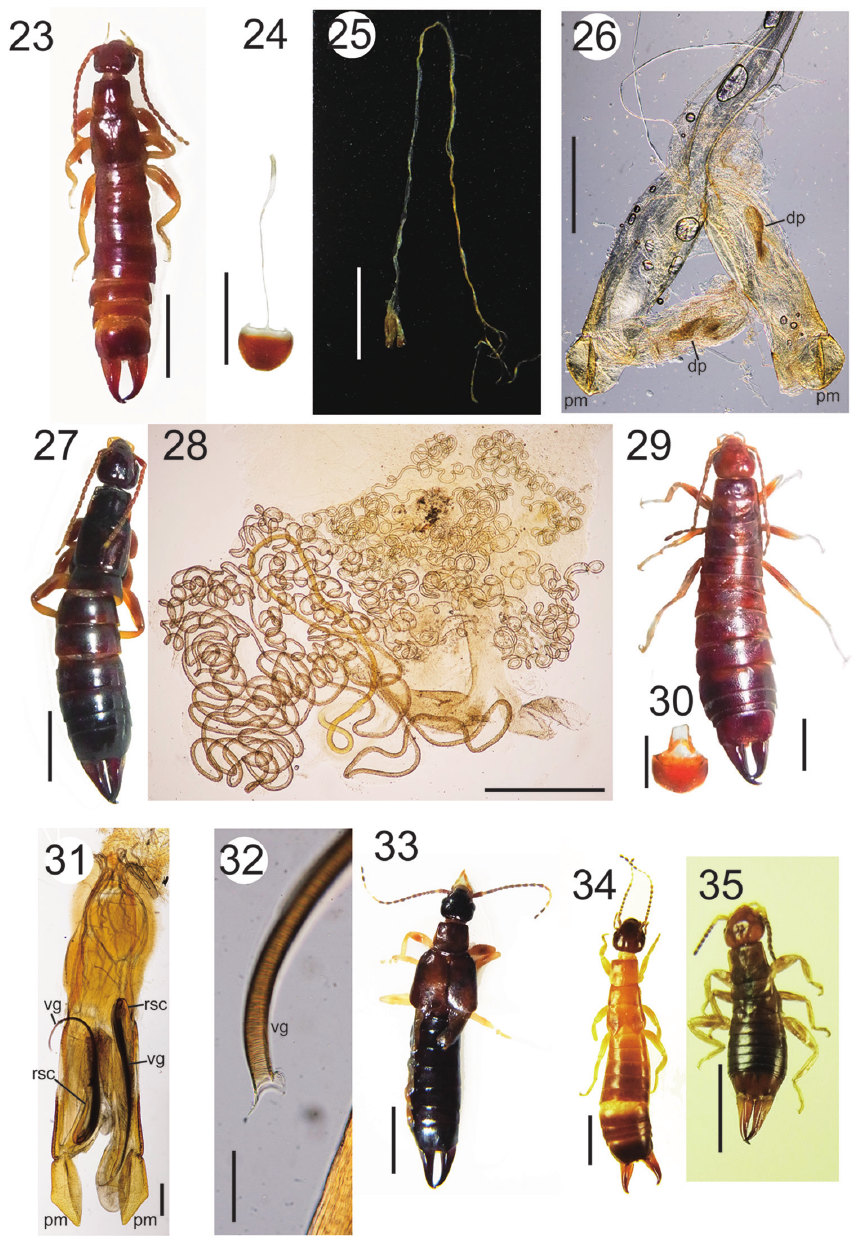
genitalia ( 25, 26 ) 27–28 Euborellia janeirensis (female): habitus ( 27 ), and spermatheca ( 28 ) 29–32 Euborellia brasiliensis (male): habitus ( 29 ), penultimate sternite + manubrium ( 30 ), and genitalia ( 31, 32 ) 33 Anisola- bididae gen. sp. 1 (female): habitus 34 Anisolabididae gen. sp. 2 (nymph): habitus 35 Anisolabididae gen. sp. 3 (nymph) habitus. Scale bars 3 mm for Figs 23–25, 27, 29, 30, 33–35 ; 0.5 mm for Figs 26, 28, 31 ; 100 μm for Fig. 32